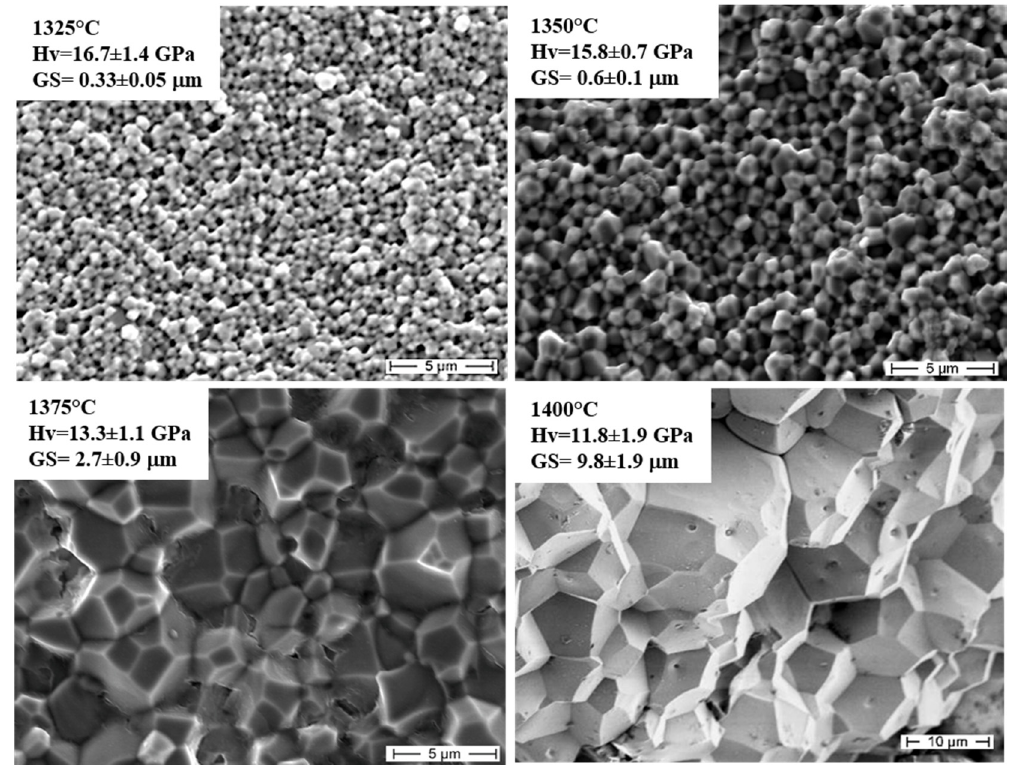
Figure 6. Field Emission Scanning Electron Microscopy (FESEM) micrographs of Y 3 Al 5 O 12 (YAG) sintered by Spark Plasma Sintering (SPS) at increasing temperatures (Hv = average Vickers hardness; GS = average grain size)